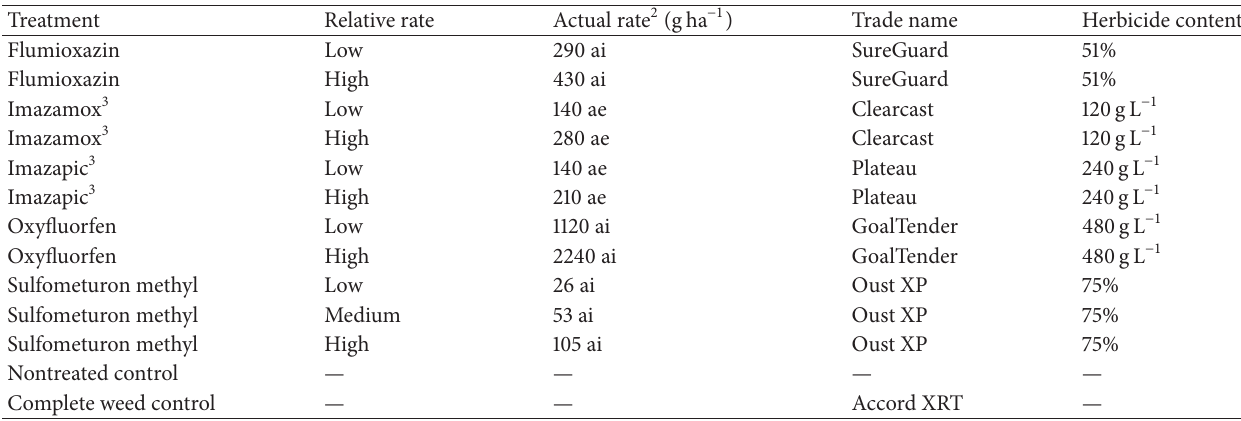
Table 1: Herbicide treatments tested for selective weed control in Eucalyptus urograndis clonal plantation culture near Quincy, Florida, applied over the top of newly planted container-grown cuttings 1 , either prior to weed emergence (PRE, two weeks after planting) or after weed emergence (POST, six weeks after planting), compared to a nontreated control and near complete weed control obtained using repeated glyphosate herbicide sprays, carefully directed to weeds while shielding seedlings from spray contact. Treatment Relative rate Actual rate 2 (g ha −1 ) Trade name Herbicide content Flumioxazin Low 290 ai SureGuard